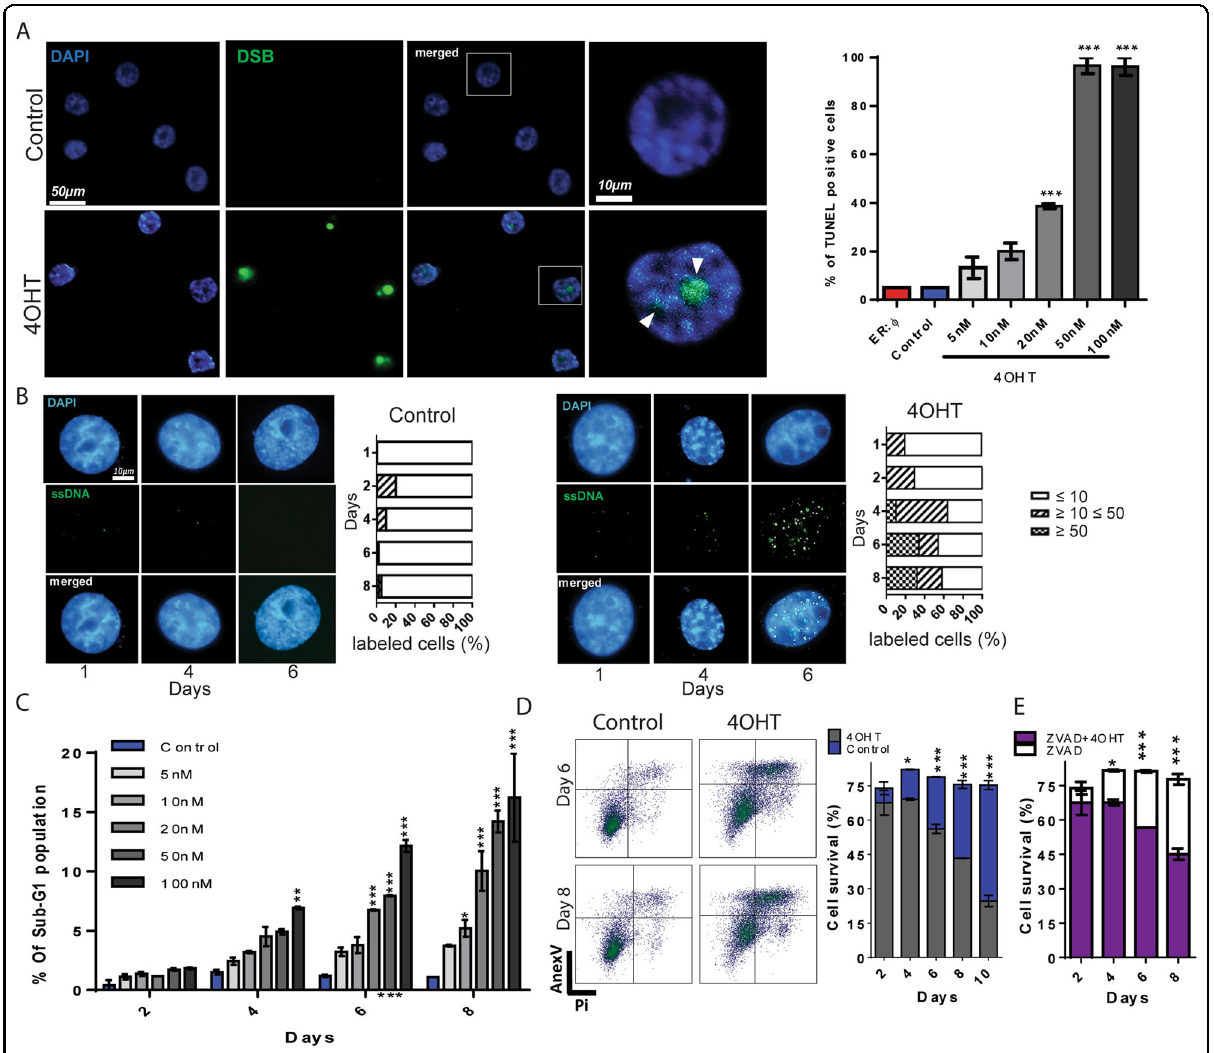
Fig. 3 The oncogenic stress triggered by high HRas G12V activity causes DNA damage leading to cell death. A TUNEL assays showed high levels of DNA strand breaks (DSB) in cells after six days of 4OHT induction in a dose-dependent manner. Two groups of controls were used: noninduced ER:HRas G12V keratinocytes and ER:ø-keratinocytes treated with 50 nM of 4OHT emphasizing that the increasing levels of HRas G12V , but not 4OHT, are responsible for DNA breaks, n = 100 cells per condition. The whole experiment (including the experimental controls and the other 4OHT concentrations used), is presented in Supplementary Fig. S4. B In ER:HRas G12V keratinocytes, native chromatin-BrdU assay showed persistent sites of single-stranded DNA (ssDNA) after six days of 50 nM 4OHT induction. For each condition and day analyzed, at least 50 nuclei were counted and classi fi ed into three different phenotypes: normal ≤ 10 foci/nucleus, the initial stage of replication stress ≥ 10 ≤ 50 foci/nucleus, and advanced stage of replication stress ≥ 50 foci/nucleus. The whole kinetic experiment is displayed in Supplementary Fig. S5. C Sub-G1 populations increased with dose and time of HRas G12V induction. The graph is representative of two independent experiments carried out in duplicate. D Annexin-V/PI- fl ow cytometry analyses: ER:HRas G12V keratinocytes induced with 50 nM of 4OHT and the noninduced control condition were analyzed for 10 days. Density plots are presented as an example of the pro fi le of ER:HRas G12V keratinocytes in days 6 and 8. E In the same kinetic design, the treatment with 25 µM of the caspase inhibitor ZVAD did not rescue the viability of keratinocytes under high HRas G12V activity. The graphs are representative of three independent experiments. For fl ow cytometry, 30 × 10 3 cells were considered per condition and time point. Data presented as a mean (SD). One-way ANOVA for B and two-way ANOVA for C and D. * P ≤ 0.05, ** P ≤ 0.01, and *** P ≤ 0.001, Bonferroni post